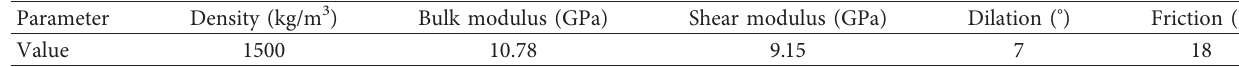
Table 3: Material parameters for simulating goaf.